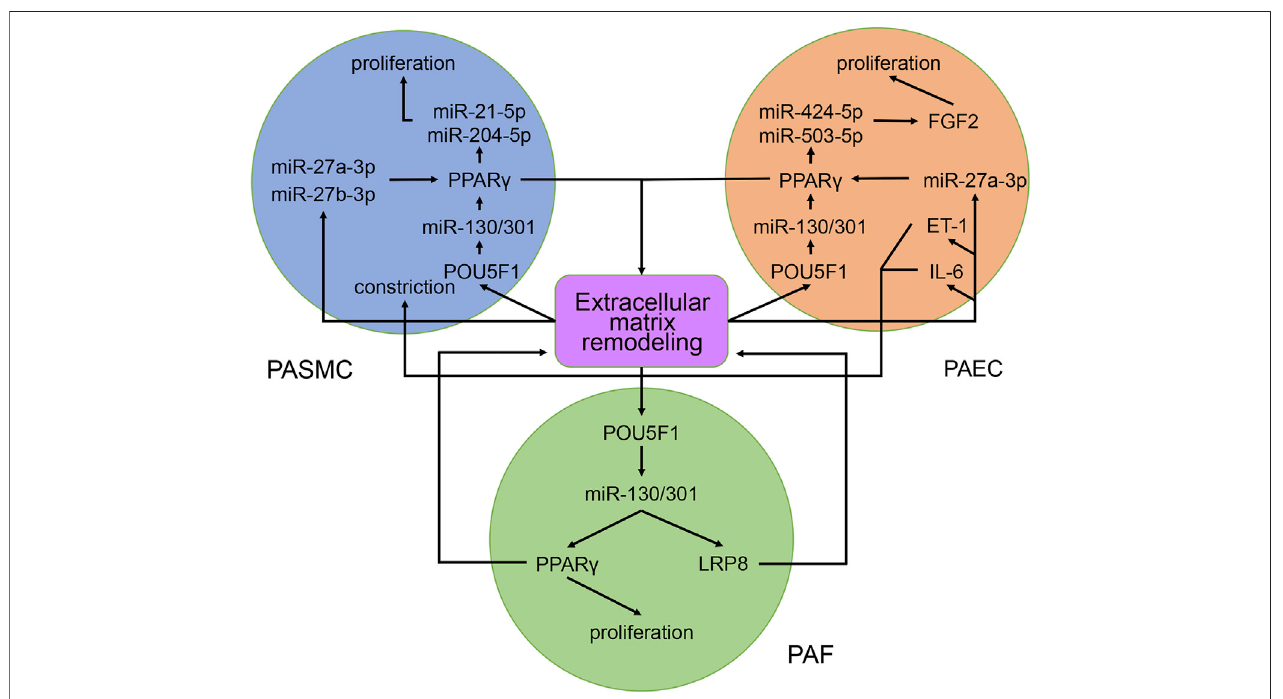
FIGURE 9 | Contribution of the miR-130/301 family to the crosstalk between various pulmonary artery cells. The remodeled extracellular matrix induces proliferationandcontractioninpulmonaryarterycellsviamiR-130/301family-dependentand -independent pathways. Meanwhile,matrixremodelingcanbeinducedby overexpression of the miR-130/301